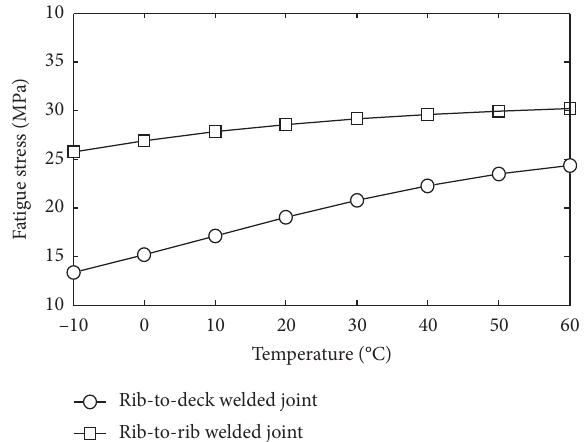
Figure 5: The correlation between fatigue stress and